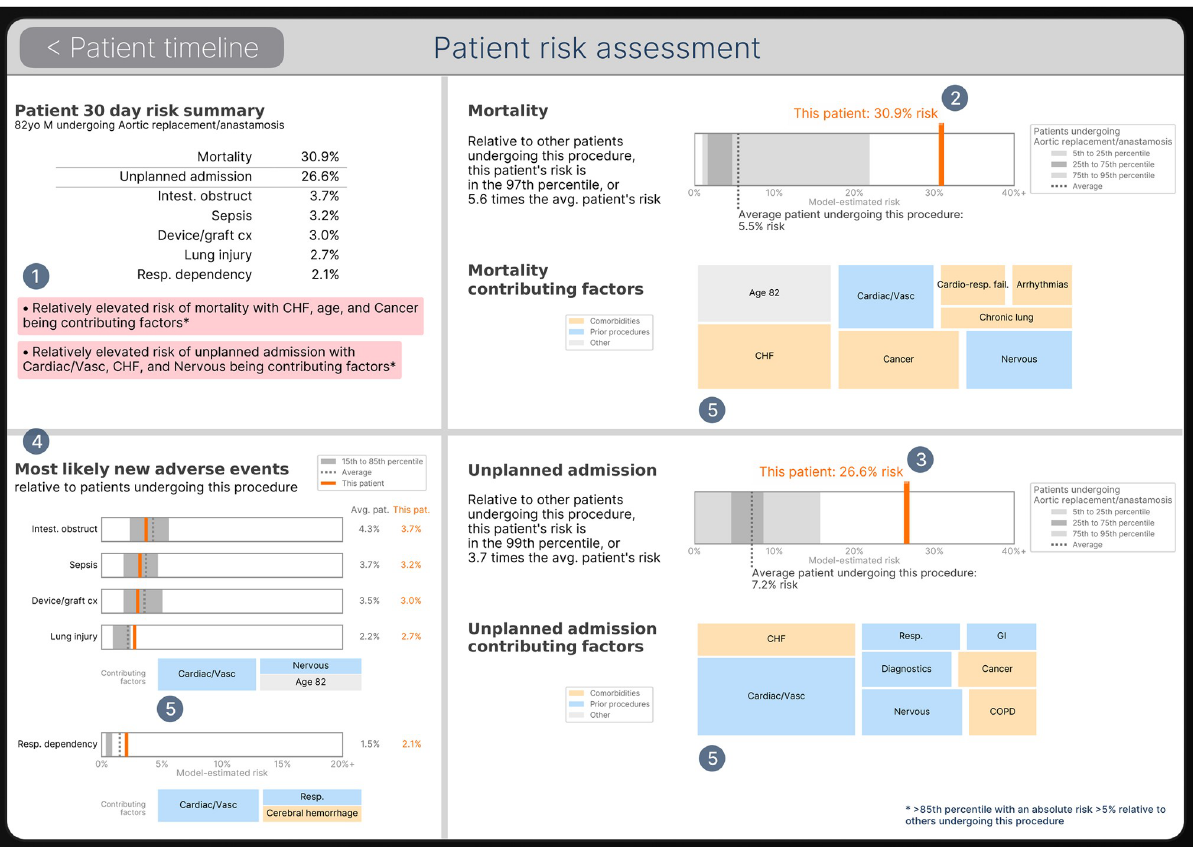
Fig 4. Example output from clinician-facing software risk tool. Descriptors on risk context and contributors correspond to the numbers in Fig 4 as follows: (1) Clinically-determined risk criteria were defined to determine when to display message boxes with below average risk (green), above average risk (yellow), and relatively elevated risk (red) messages. (2) Patient’s individual risk of 30-day mortality (as estimated by the XGB model) is presented as relative to the average risk of 30-day mortality among all patients undergoing the same procedure (e.g. aortic surgery). (3) Patient’s individual risk of unplanned admission is presented as relative to the average risk of unplanned admission among all patients undergoing the same procedure (e.g. aortic surgery). (4) Summarizes individualized risk of the most likely adverse events; presented as relative to the average risk for a given adverse event among all patients undergoing the same procedure (e.g. aortic surgery). (5) Factors (e.g. preexisting comorbid diseases, or previous procedures) contributing to risk are scaled and sized (as estimated by logistic regression) to reflect relative contribution to overall